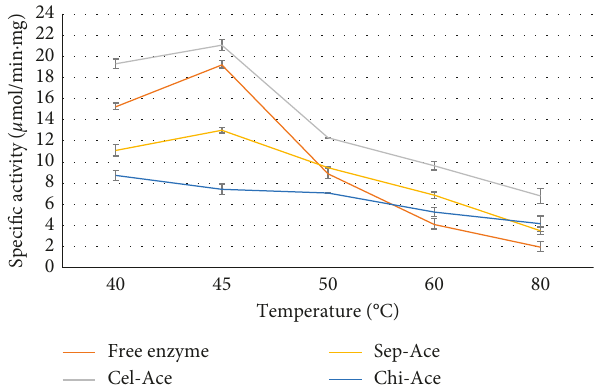
Figure 2: Specific hydrolytic activity of acetone-immobilized samples with varying pH values (temperature 45 ° C and [S]